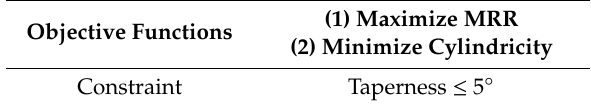
Table 5. Objective functions and constraints of the formulated optimization problem.